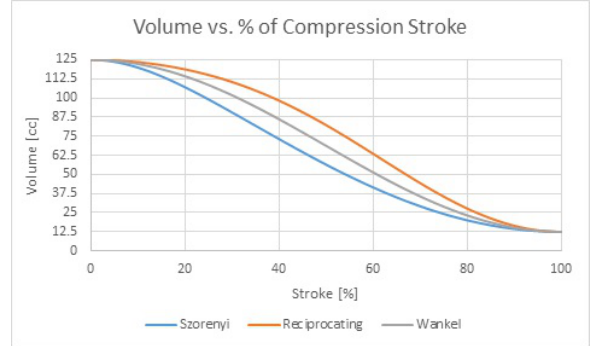
Fig. 6: Volume vs % of compression phase